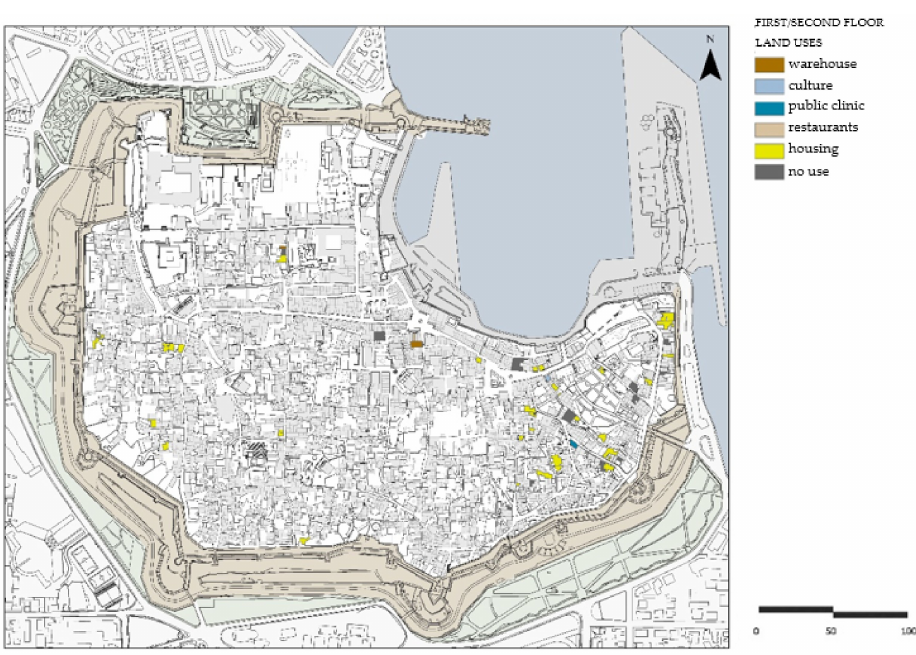
Figure 8. Land uses (1st/2nd floor).